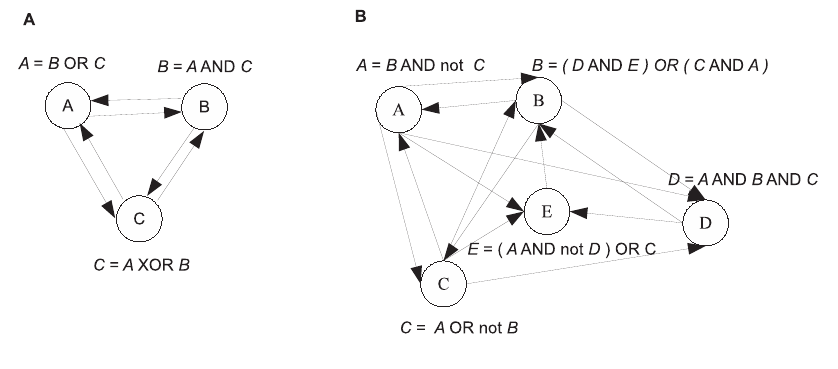
Figure 5. Network of 3 and 5 nodes.